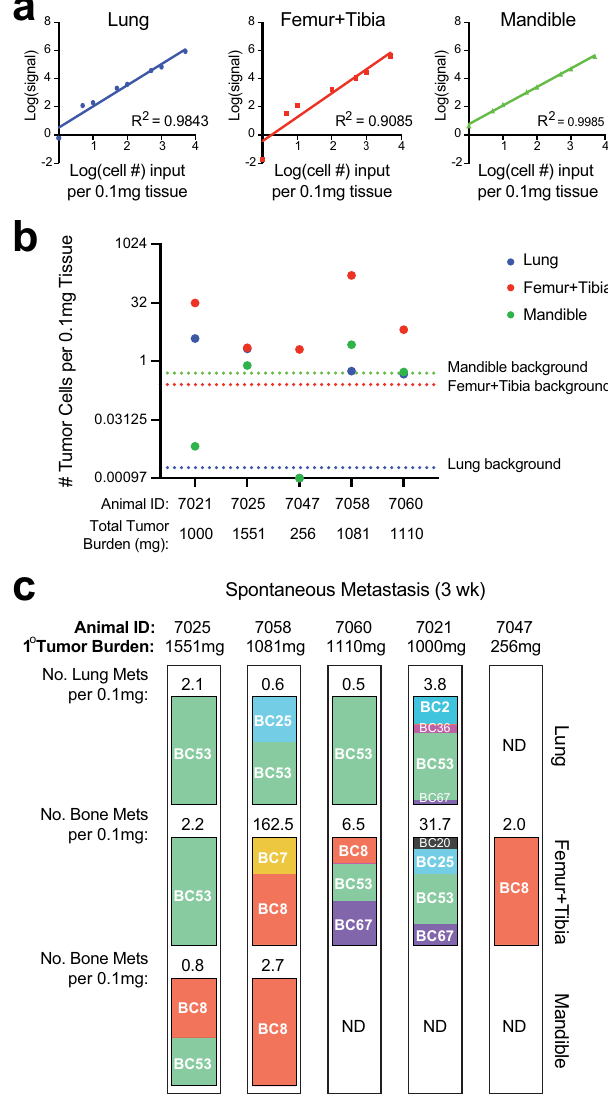
Fig. 5 SunCatcher enables identi fi cation and quanti fi cation of early spontaneous metastasis. a Calibration curves were generated for indicated tissues by serially diluting known amounts of barcoded tumor cell gDNA into a fi xed amount of normal tissue gDNA. From left to right: lung, long bones (from femur and tibia), mandible. b 2.5×10 5 barcoded Met1 tumor cells were injected bilaterally into the mammary fat pads ( n = 5 animals) and tumors were allowed to grow for 21days, at which point tissues were harvested and metastasis burden was calculated. Dashed lines indicate the background signals from each indicated tissue type. Tissues with signal above the background were considered positive for metastasis and estimated tumor cell number per 0.1mg tissue was calculated based on the calibration curve for that speci fi c tissue. c Barcode composition analysis on tissues with positive metastasis signal. Bars represent percent of total barcode signal (100%) within each sample. Also shown are mouse identities, total primary tumor burden for each animal, and estimated numbers of metastases per tissue; N.D., not detected. Source data are provided as a Source Data fi